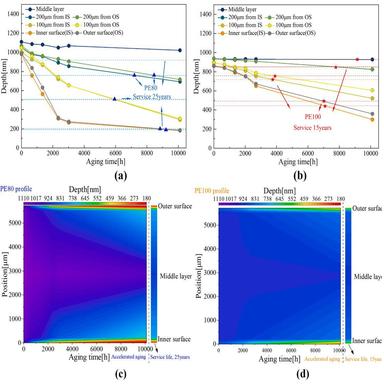
Correlation of maximum depth and position (a) PE80 and (b) PE100, contour plot (c) PE80 and (d) PE100.